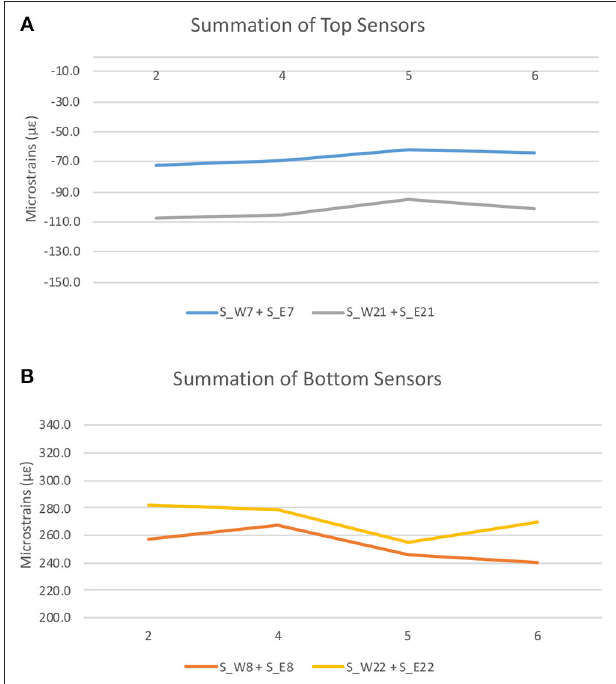
FIGURE 8 | Summation of west and east peak strains: (A) top of edge girders at midspan and controlling location; (B) bottom of edge girders at midspan and controlling